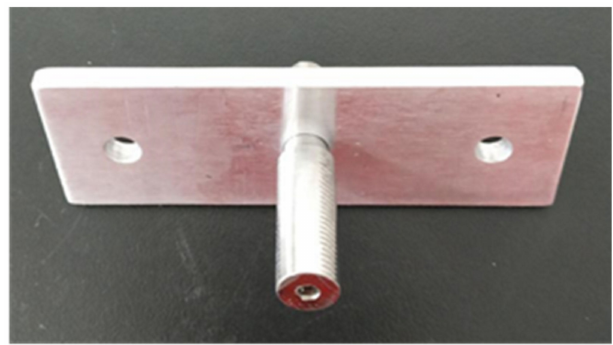
Figure 8. Test specimen of interference